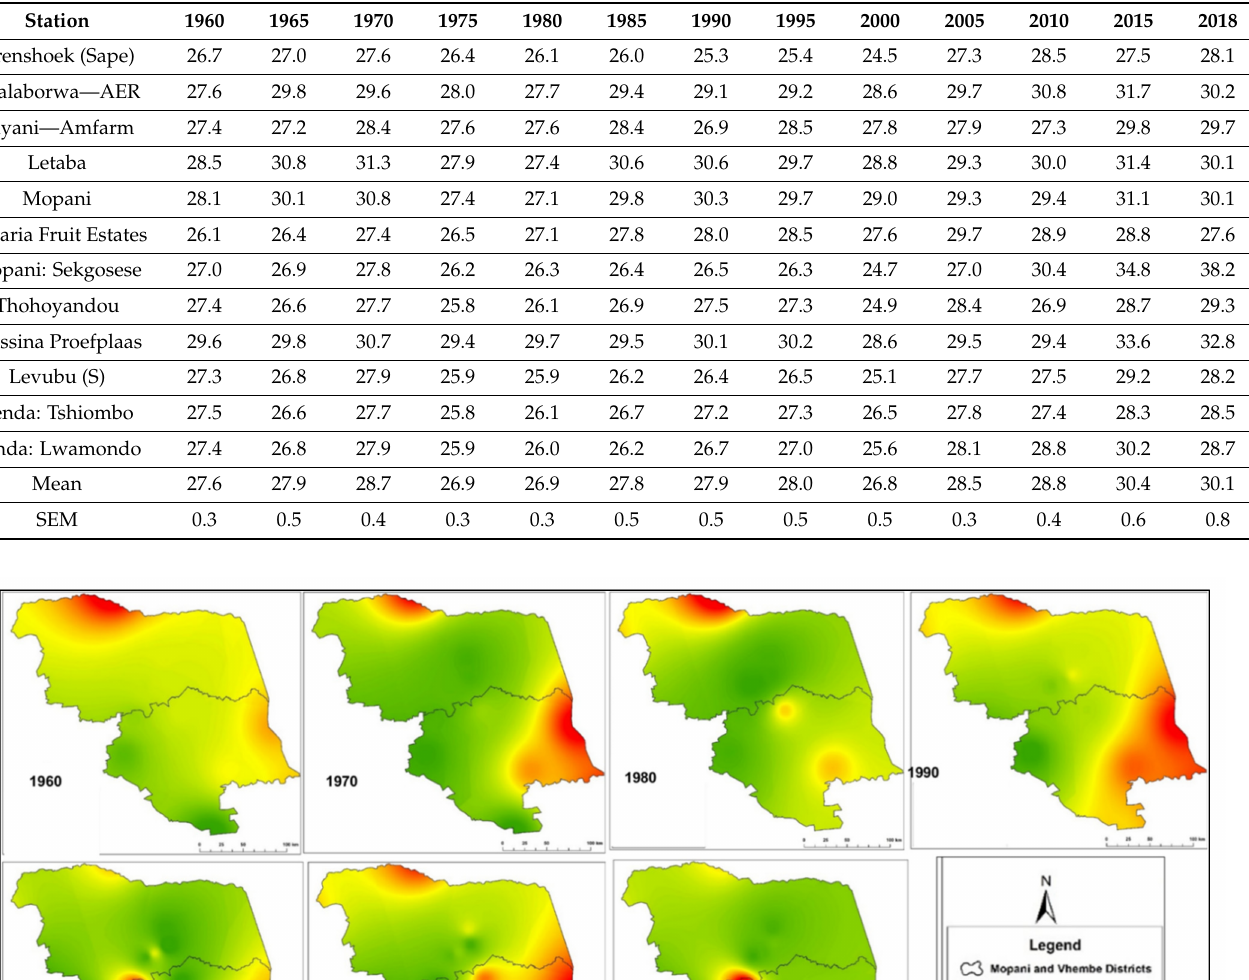
Table 5. The average annual maximum temperature in the Mopani and Vhembe districts.